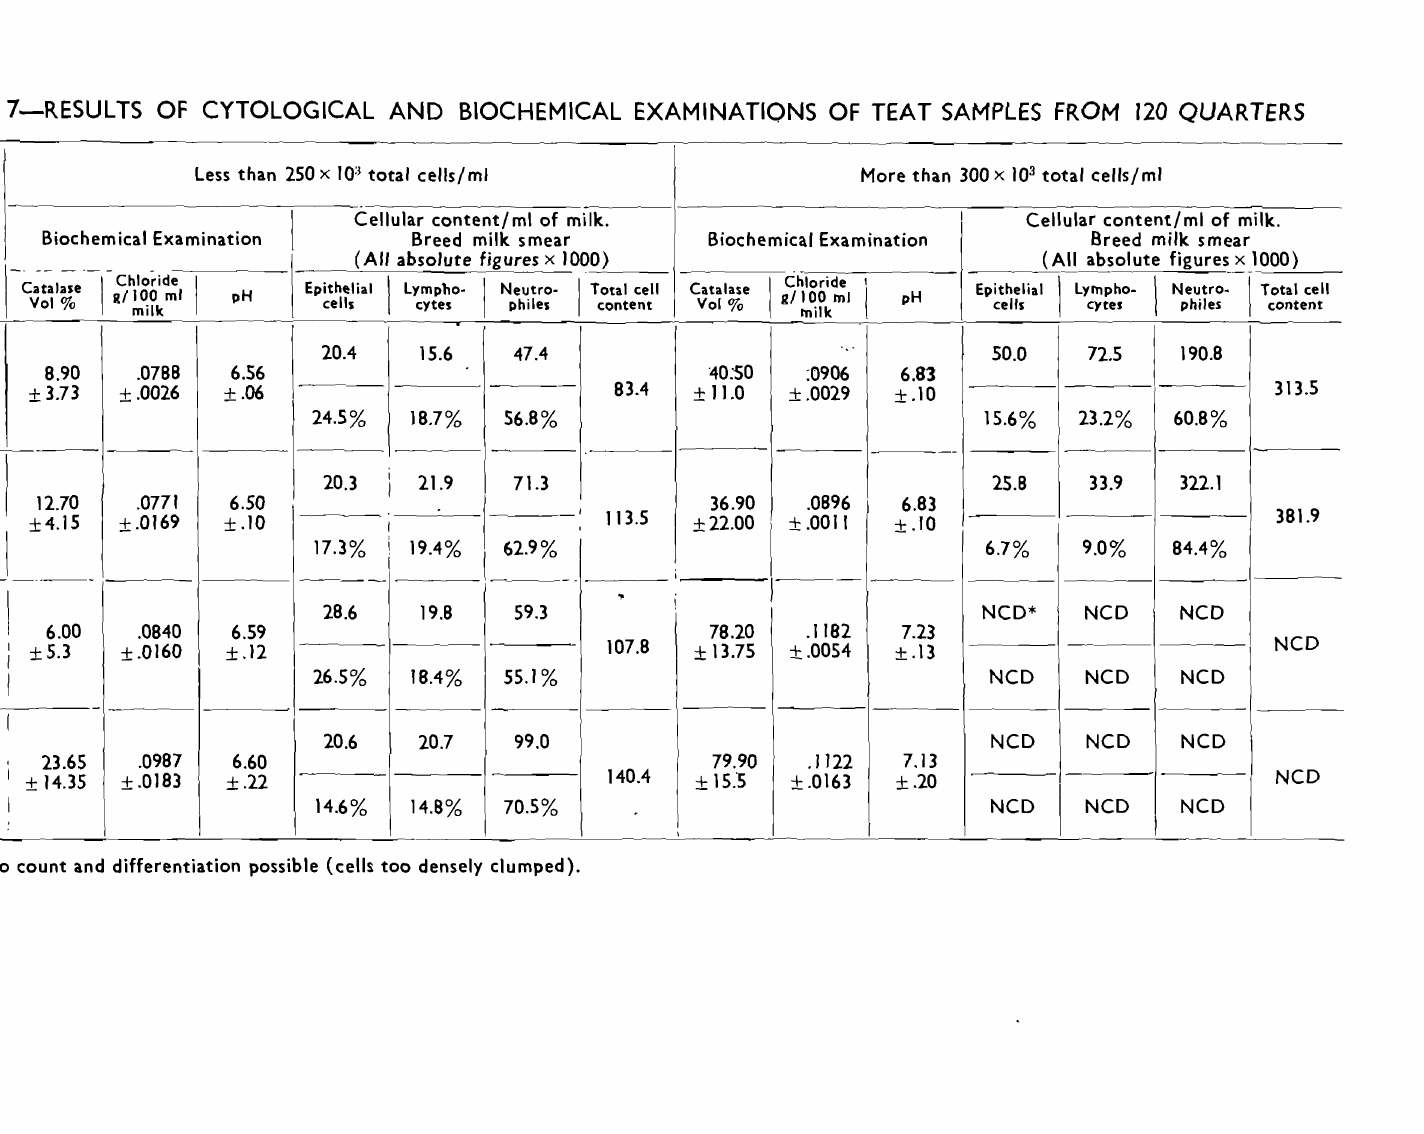
Table 7-RESULTS OF CYTOLOGICAL AND BIOCHEMICAL EXAMINATIONS OF TEAT SAMPLES FROM 120 QUARTERS '" Less than 250 x 10:l total cells/ml More than 300 x 10 3 total cells/ml ~~ ...... .. ... Cellular content/ml of milk. .~ D" coo. (All absolute figures x 1000) (All absolute figures x 1000) :::0